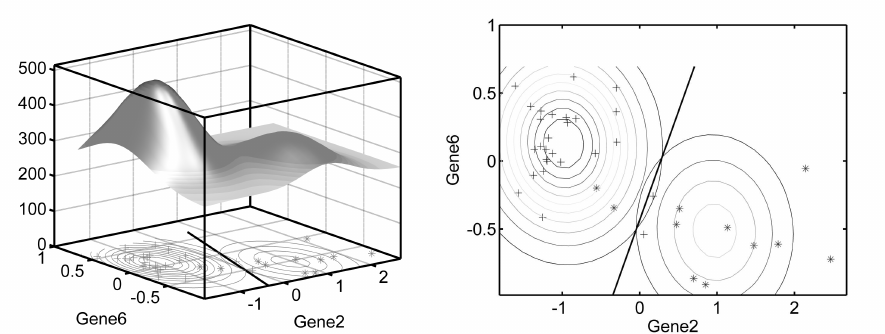
Figure 3. RLDF regularized with parameters r = 0.2 and s = 0.5; apparent error = 0.105, CV = 0.105 (SD =